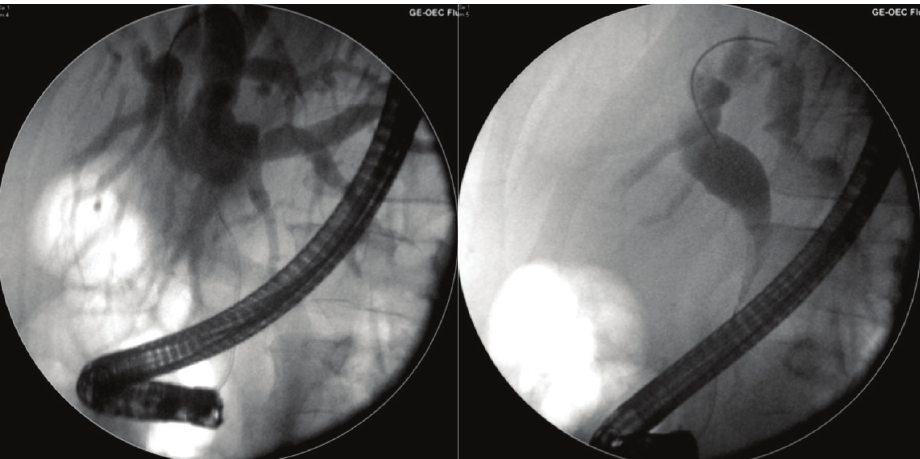
Figure 4: Endoscopic retrograde cholangiopancreatography (ERCP) images with dilated biliary tree down to a strictured distal bile